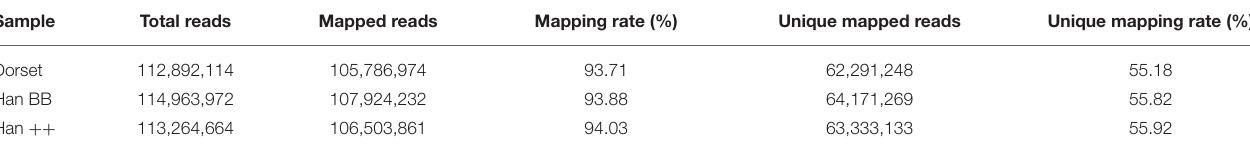
TABLE 1 | MeDIP-Seq Illumina data.